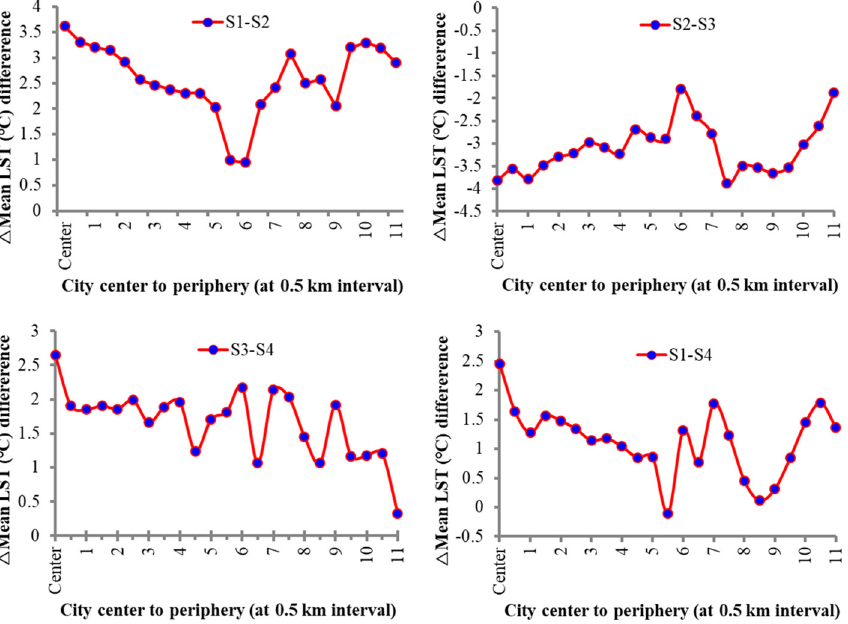
Figure 5. Magnitude of the summer mean LST in different periods (1988–2018). Between S1 and S2 , the mean LST observed amplifying pattern ranged from 0.94 ◦ C to 3.62 ◦ C, wherein the lowest intensified zone was 12 (5.5–6 km) by 0.94 ◦ C because there was existence of grass and forest land. The highest intensified zone was 0 (city center) by 3.62 ◦ C because of the presence of highly dense, impervious land. Between S2 and S3 , the difference in mean LST observed a declining pattern which ranged from − 1.80 ◦ C to − 3.88 ◦ C, wherein the lowest decline zone was 12 (5.5–6 km) by − 1.80 ◦ C because of the dominance of grass and forest land, but the highest declined zone was 15 (7–7.5 km) by − 3.88 ◦ C because of the dominance of sand and barren land. Between S3 and S4 , the difference in mean LST was found in an amplifying pattern that ranged from 0.33 ◦ C to 2.65 ◦ C, wherein the lowest intensified zone was 22 (10.5–11 km) by 0.33 ◦ C because of the presence of grassland. The highest intensified zone was again 0 (city center) by 2.65 ◦ C because of the presence of highly dense, impervious land. Between S1 and S4 , the difference in mean LST showed an increasing pattern which ranged from 0.12 ◦ C to 2.45 ◦ C except for zone 11 (5–5.5 km), in which the magnitude of mean LST declined by − 0.10 ◦ C because of forest and grassland, wherein the lowest intensified zone was 17 (8–8.5 km) by 0.12 ◦ C because of the presence of the Ganga River flow. The highest intensified zone again was 0 (city center) by 2.45 ◦ C because of the presence of highly dense, impervious land. The magnitude of the winter mean LST difference distributional pattern between distinctive periods on the basis of multiple ring profiling was also extracted at 0.5 km intervals from the center of the city to the periphery of the city (Table 5 and Figure 6). It was detected that each zone at each period witnessed lower temperatures in comparison to its preceding time points by a significant amount except for the period between W3 and W4. This means that a substantial temperature reduction was experienced in each zone from the city center to the periphery. However, an amplifying trend was observed during the period of